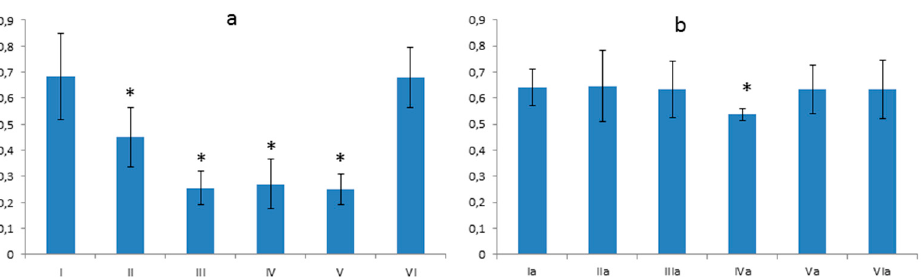
Figure 7. The membrane thickness of the capillary tuft. ( a ) Differences between the control group— I and groups II , III , IV , V were statistically significant at p = 0.05 (and signed by *); ( b ) Difference between the control group— Ia and IVa group was statistically significant at p = 0.05 (and signed by *). Vertical scale units expressed in µm.